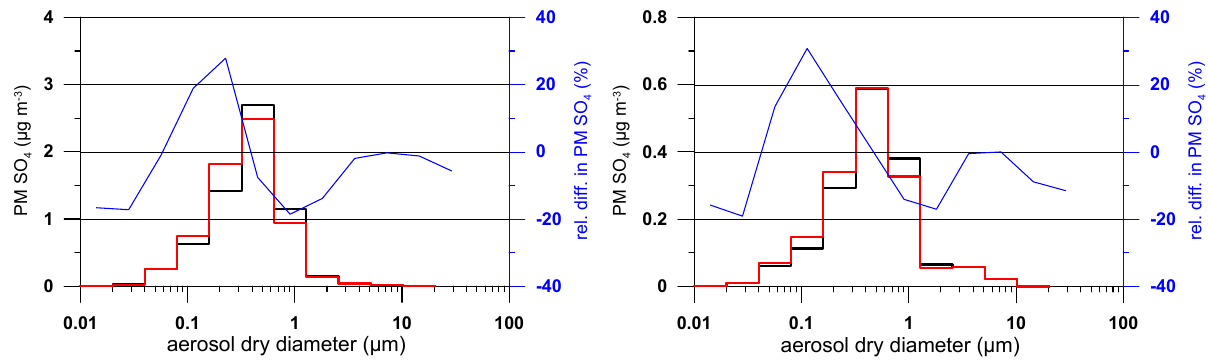
Figure 3. Modeled average PM sulphate size distribution at two IMPROVE sites: Dolly Sods, WV (left) and Presque Isle, ME (right); black lines—base case (Jones scheme), red lines—sensitivity (Abdul-Razzak & Ghan scheme), blue lines—relative difference between the sensitivity and the base-case